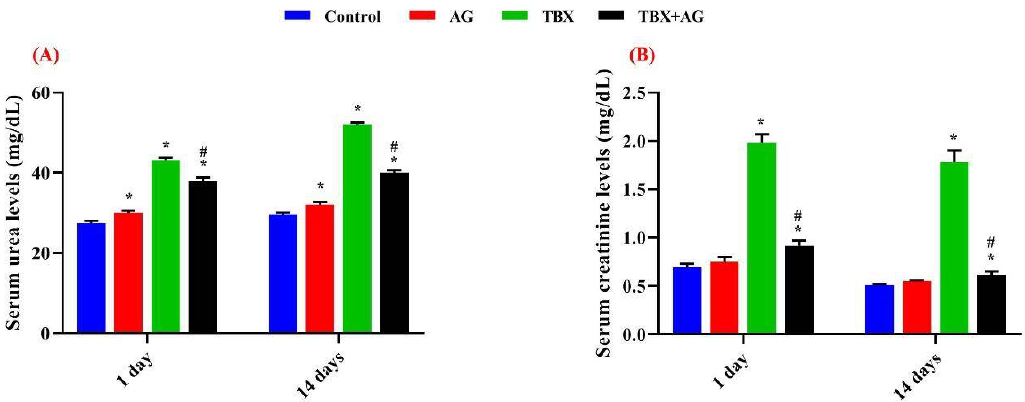
Figure 1. The protective effect of Arabic gum ( Acacia senegal , AG) against the Telebrix (TBX)-induced alterations at the levels of serum urea ( A ) & creatinine ( B ) in treated rats after 1 and 14 days of the experiment. *: Significant ( p < 0.001) relative to untreated groups. #: Significant ( p < 0.001) relative to TBX-treated groups. Data were represented as mean ± SE of three independent experiments ( n = 5). AG: 10% Arabic gum, TBX: Telebrix (1600 mg/kg b.wt.) and TBX+AG: co-treatment with 1600 mg/kg b.wt. and 10% Arabic gum.